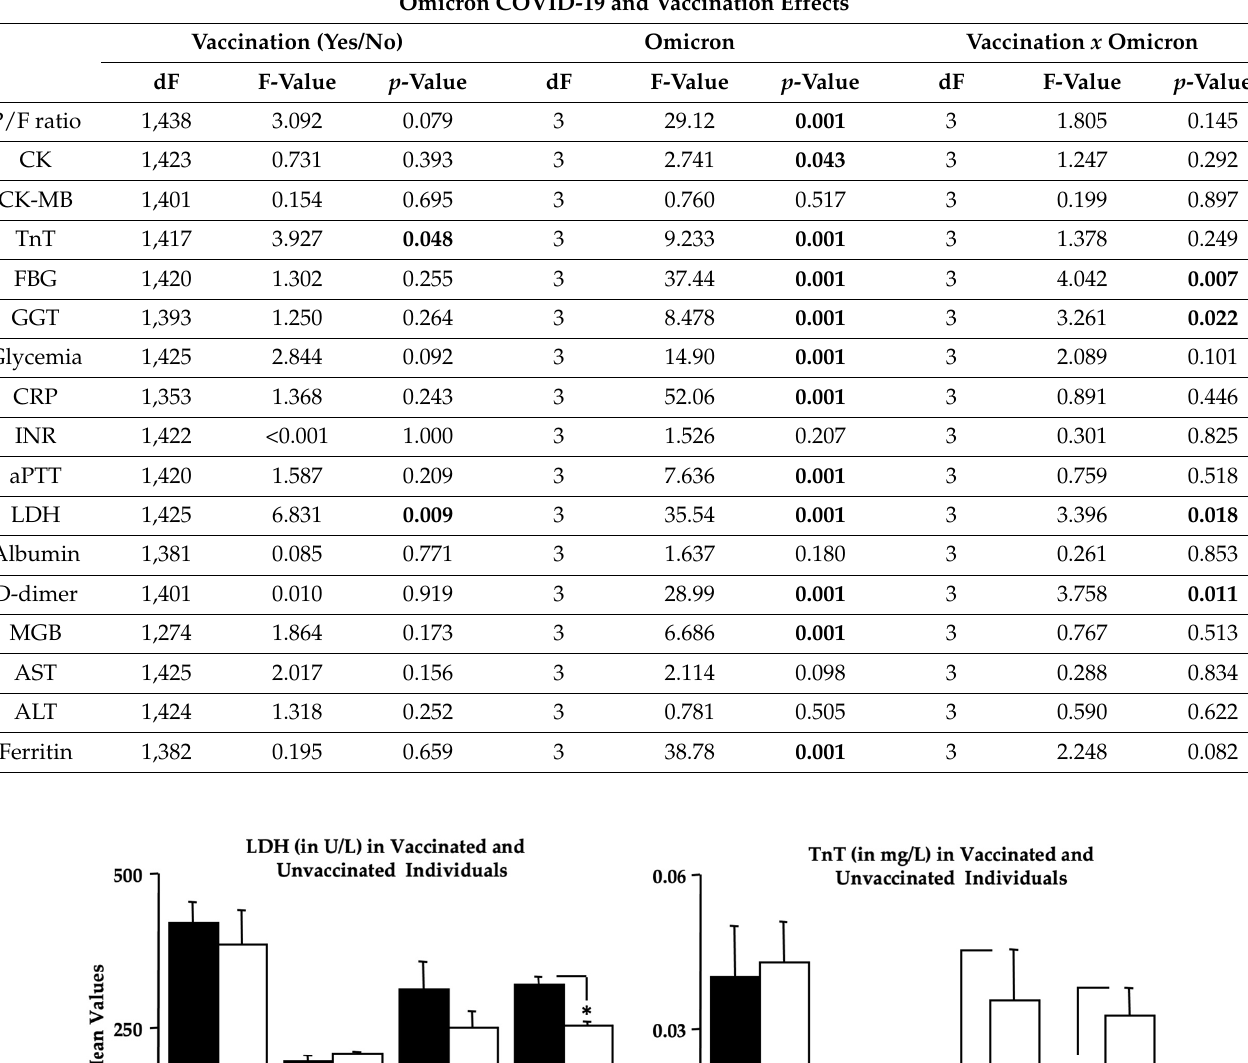
Table 8. Vaccination effects on the single analyzed biomarkers in a two-way ANOVA. The sex effect was not considered because only the ferritin data differed between men and women (for ferritin, no effect was found for sex x vaccination). Significant scores are shown in bold.